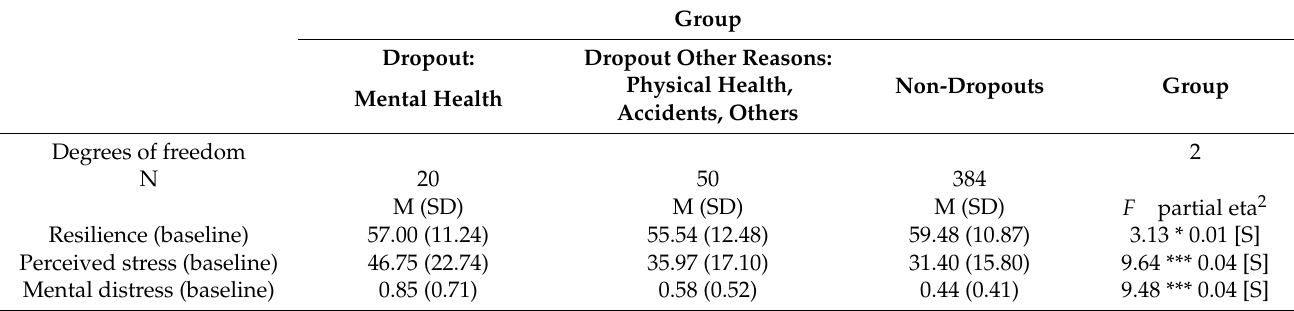
Table 5. Multivariate ANOVA for group comparisons of the mental health dropout group, the group of dropouts for other reasons, and the non-dropout group of variables resilience, perceived stress and mental distress at